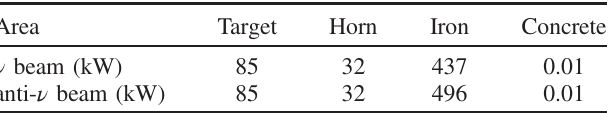
TABLE V. Energy deposition in kW for the horns, iron, and concrete around four-horn system for 4 MW proton beam.